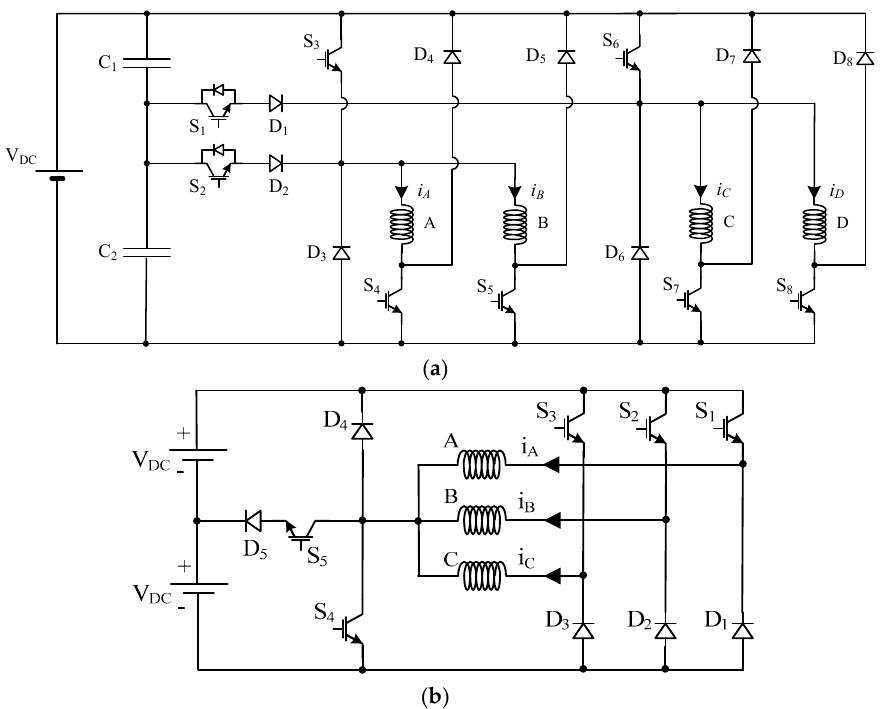
Figure 18. Multilevel converters based on two voltage sources ( a ) for an 8/6 SRM ( b ) for a generic SRM and common point of the machine.